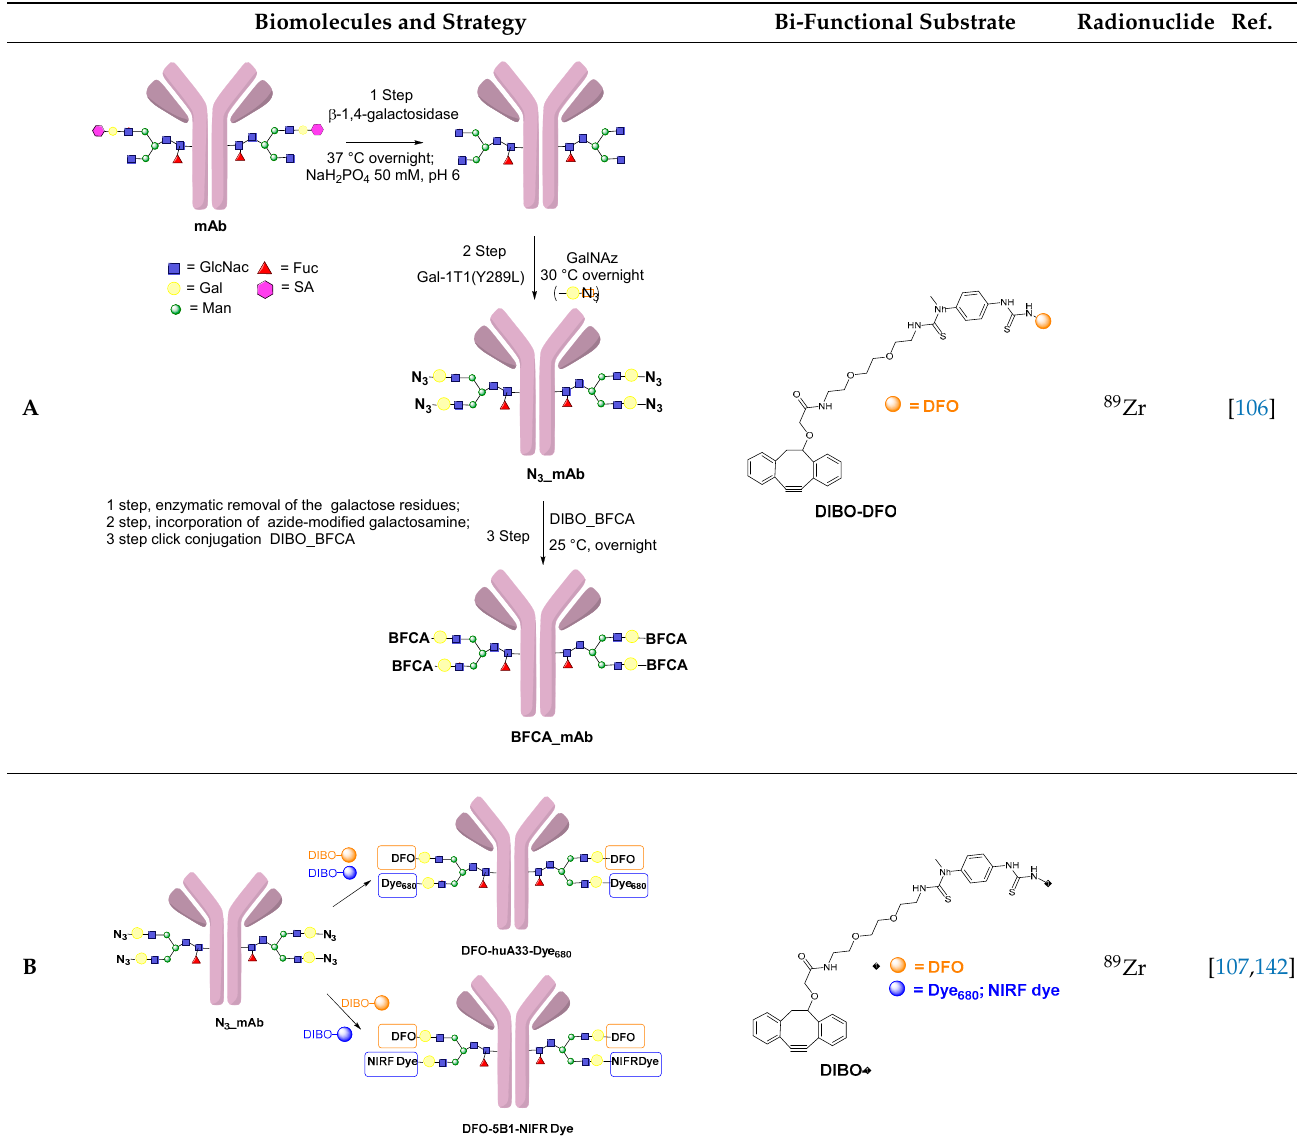
Molecules 2021 , 26 , 3492 Biomolecules and Strategy Biomolecules and Table 7. Overview of galactosyltransferase mediated conjugation in radiopharmaceutical applications. Biomolecules and Strategy Bi-Functional Substrate Radionuclide Ref.